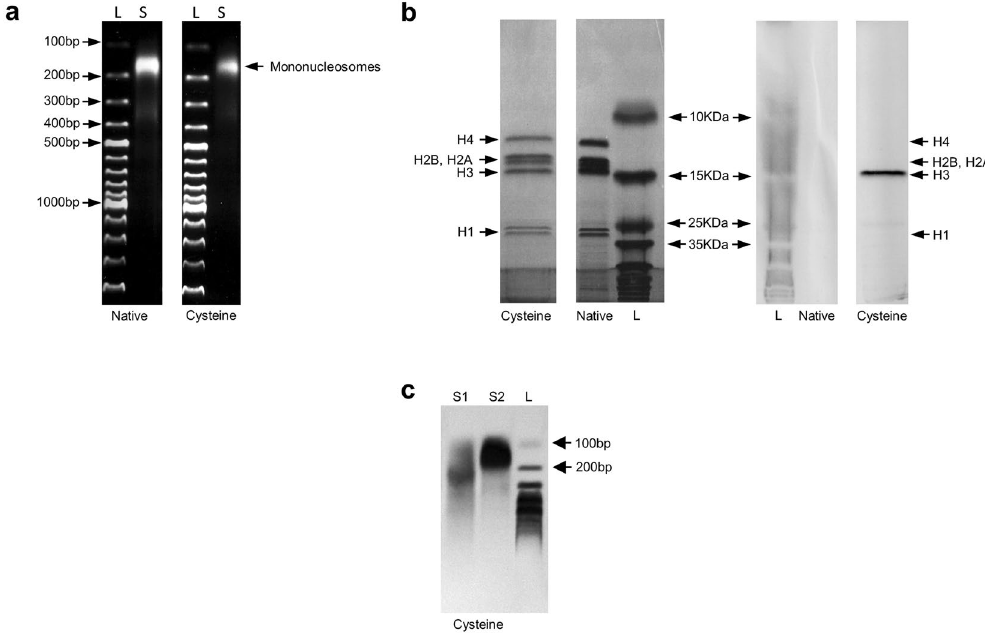
Figure 2. Characterization of native and labeled nucleosomes (cropped gel). ( a ) Analysis of nucleosome DNA content (500 ng of DNA) by agarose gel (1.2%) after proteinase K digestion. L: ladder; S: sample. ( b ) Analysis of nucleosome proteins (equivalent to 1.5 µ g of DNA) by SDS/PAGE (18%) after Coomassie Blue staining ( left ) or under UV light before Coomassie Blue staining ( right ). Native: native nucleosome; Cysteine: cysteine nucleosome. ( c ) Analysis of cysteine nucleosome DNA content (500 ng of DNA) by agarose gel (1.2%) before (S1) or after (S2) proteinase K digestion. L: ladder; S: sample. The non-cropped images of the gels are presented in Supplementary Fig.